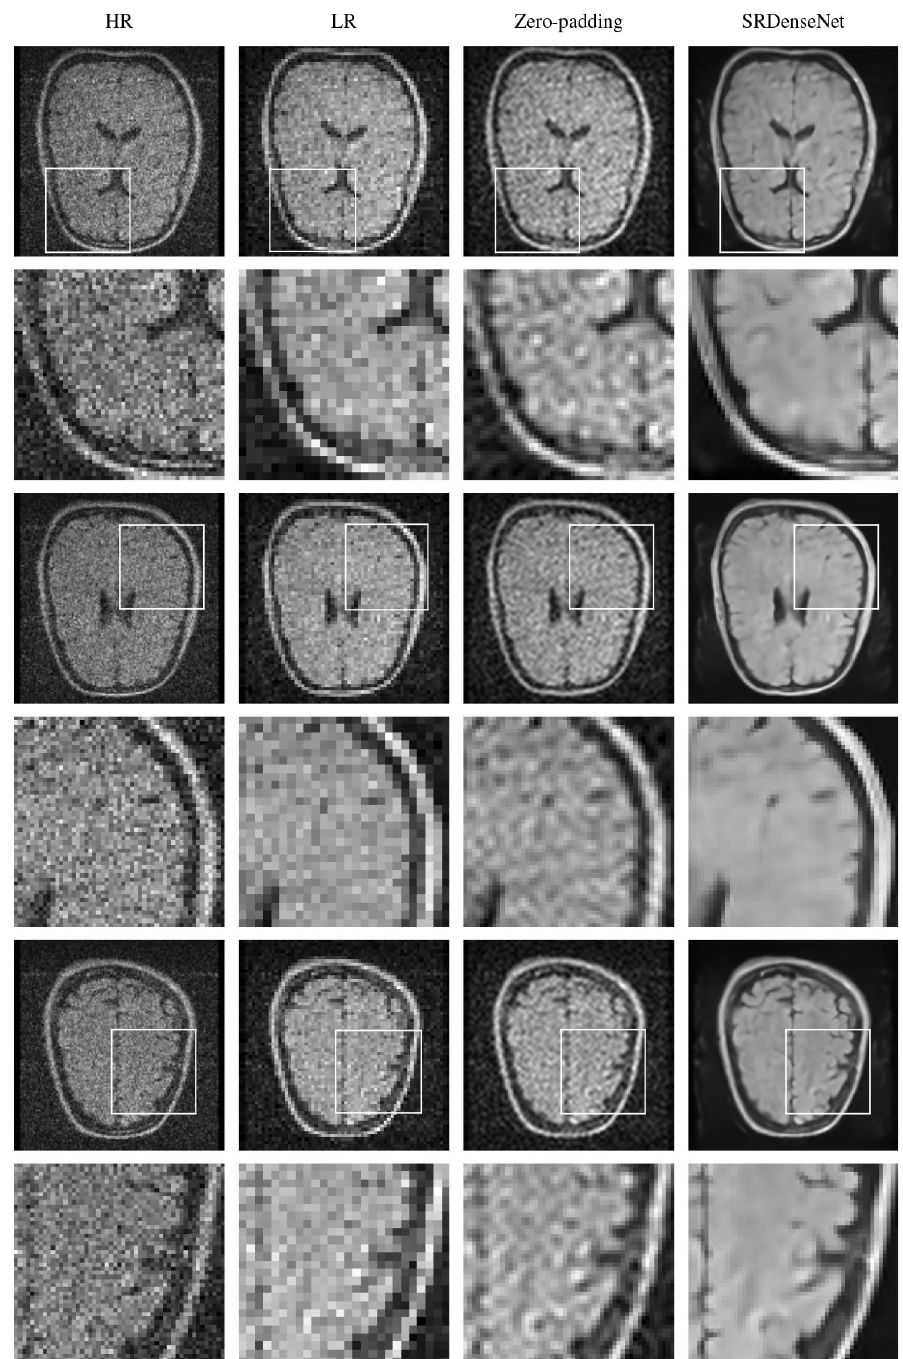
Figure 6. In the first column, we have three different HR slices of a second brain image acquired using a low- field MRI scanner. Again, these HR images are our reference images. The first, third and fifth rows show the full images, in the second, fourth and sixth rows we find zoomed-in versions of patches of the images in the first, third and fifth rows. The second column shows the LR images corresponding to the HR images in the first column. These images are fed into the trained convolutional neural network. The third column shows the SR images obtained by zero-padding k-space, and in the fourth column, we see SR images obtained by applying